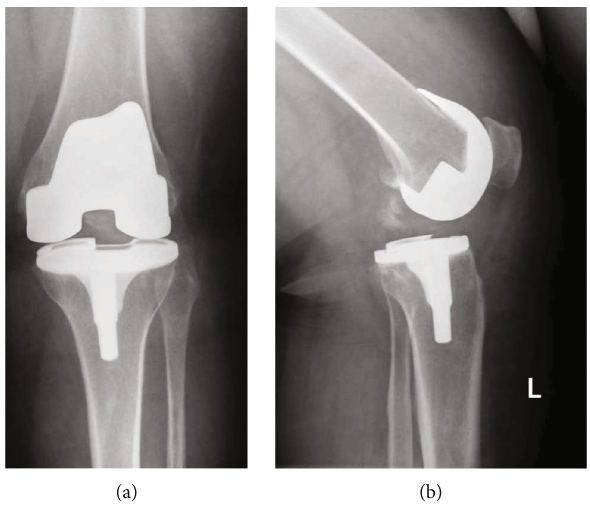
Figure 4: (a) Anteroposterior radiograph of case 4 at presentation in the emergency room. (b) Lateral radiograph of case 4 at presentation in the emergency